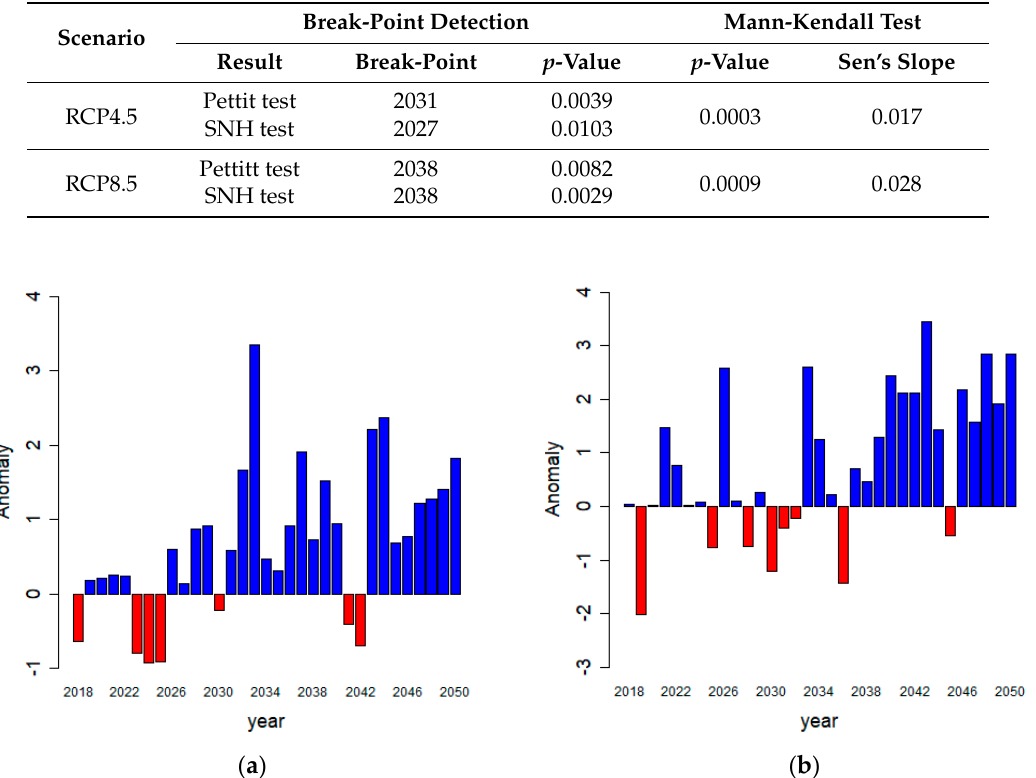
Figure 11. Temperature anomaly under RCP4.5 ( a ) and RCP8.5 ( b ).